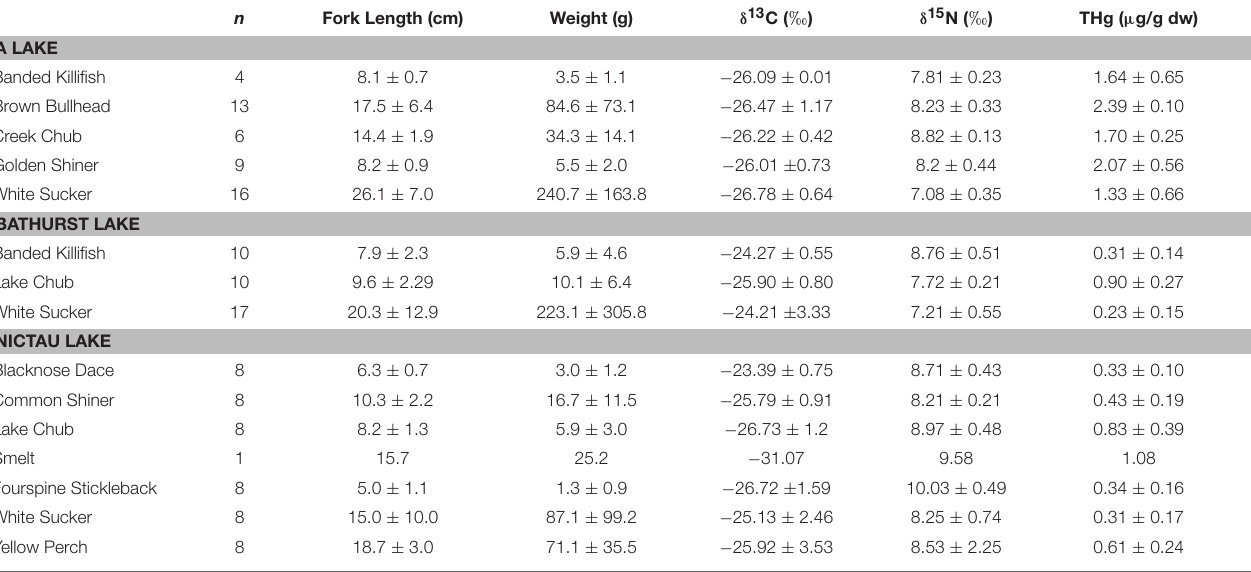
TABLE 4 | Mean ( ± SD) length (cm), weight (g), δ 13 C ( h ), δ 15 N ( h ), and THg ( µ g/g dw) of other fishes collected from A, Bathurst, and Nictau lakes in New Brunswick, Canada.